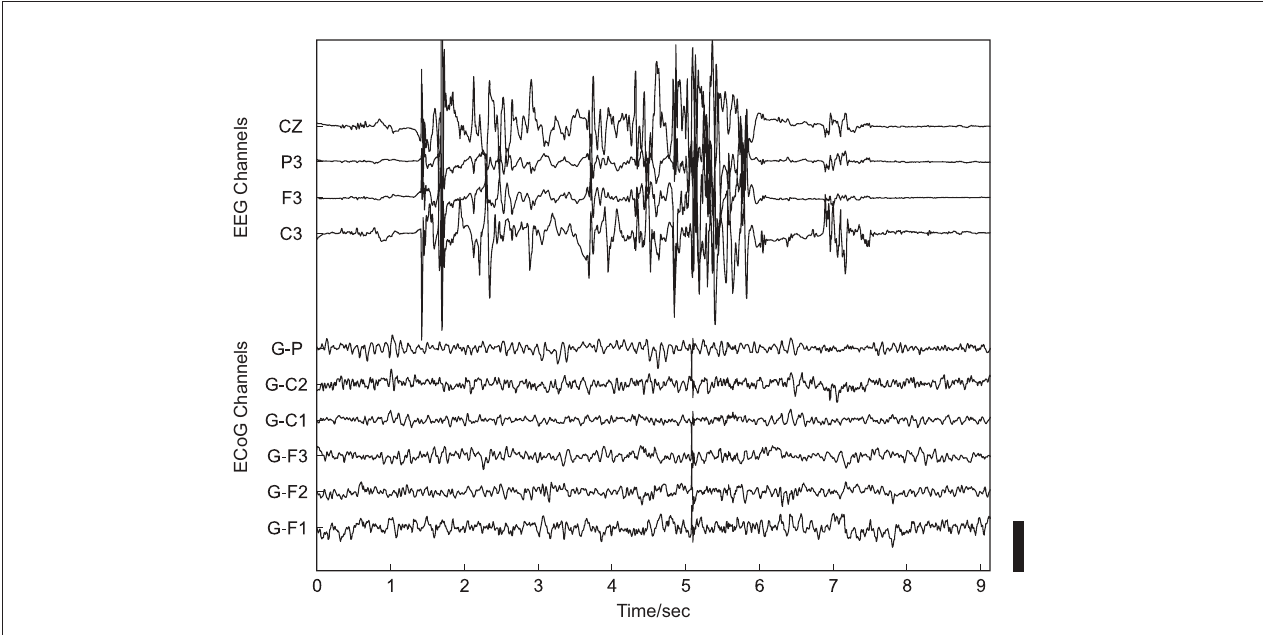
FIGURE 1 | Example of artifacts related to head movement in simultaneous non-invasive, scalp-recorded EEG (upper 4 traces) and ECoG recorded using subdurally implanted electrodes (lower 6 traces). The height of the black scale bar in the lower right corner of the plot corresponds to 100 μ V.